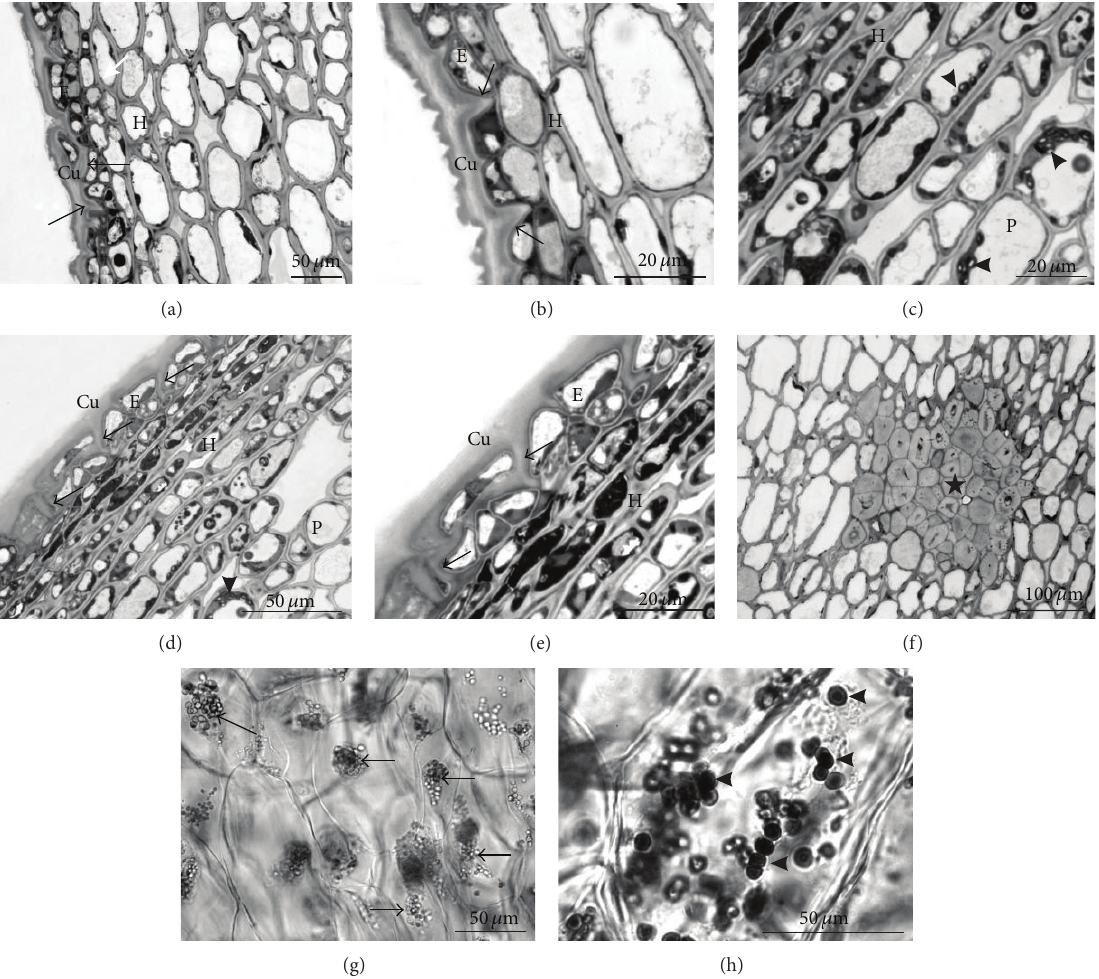
Figure 7: LM: fragments of the cross-sections through the “Clapp’s Favourite” ((a), (b)) and “Conference” ((c)–(h)) fruit peel at the harvest maturity stage; ((a)–(d)) visible cuticle penetrating the anticlinal and internal periclinal walls of the epidermis (arrows) and an irregular shape of the epidermis cells; ((c)–(e)) visible dark deposits of tannin compounds in the epidermis and hypodermis cells and plastids with starch grains in the hypodermis and parenchyma (arrowheads) (c); (f) stone cell aggregation in the parenchyma (asterisk); (g) leucoplasts with starch grains in the parenchyma (staining with IKI) (arrows); (h) deposits of tannin compounds in the parenchyma (staining with FeCl 3 ) (arrowheads); Cu: cuticle, E: epidermis, H: hypodermis, and P: